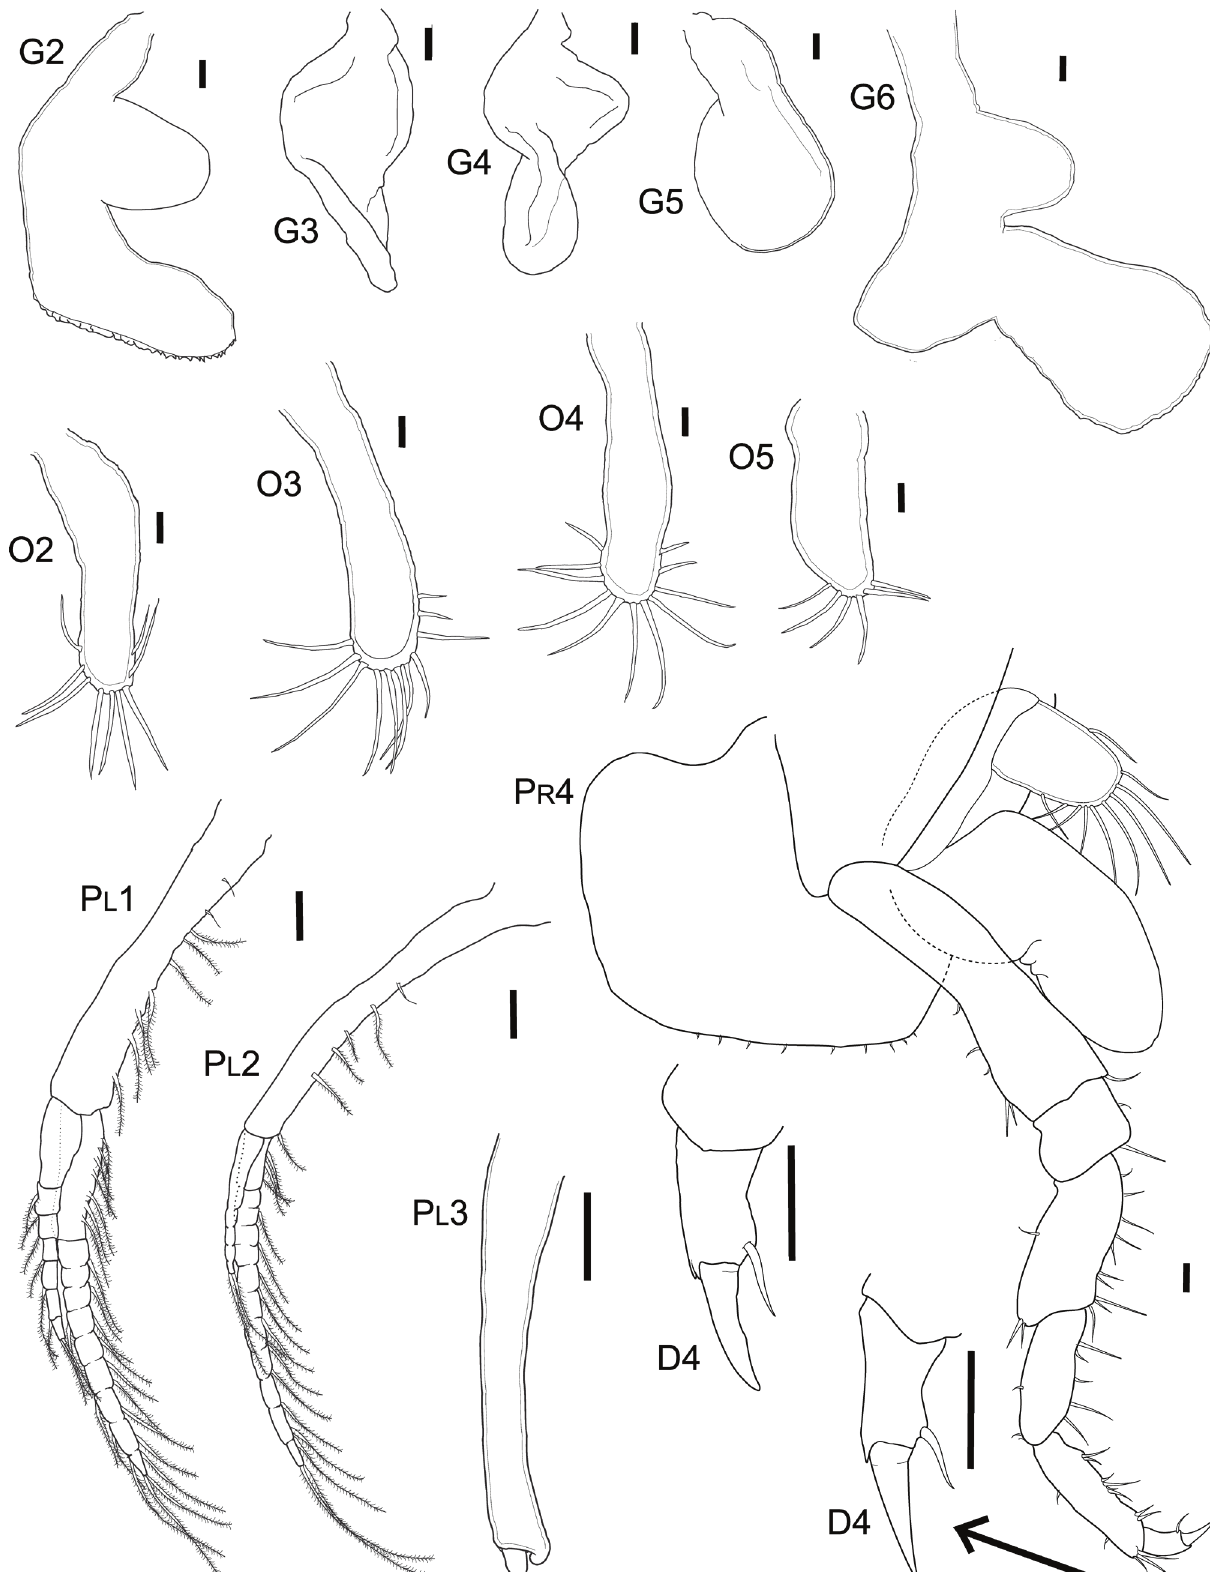
Figure 5. Talitroides topitotum (Burt, 1934). Female, 11.9 mm, MNRJ 14470: Gills, pleopods and pereopod 4 (dactyl indicated by arrow); Female, 12.2 mm, MNRJ 14470: Oostegites; Female, 15.3 mm, MNRJ 24811: Dactyl of pereopod 4 with variation. Scales = 0.1